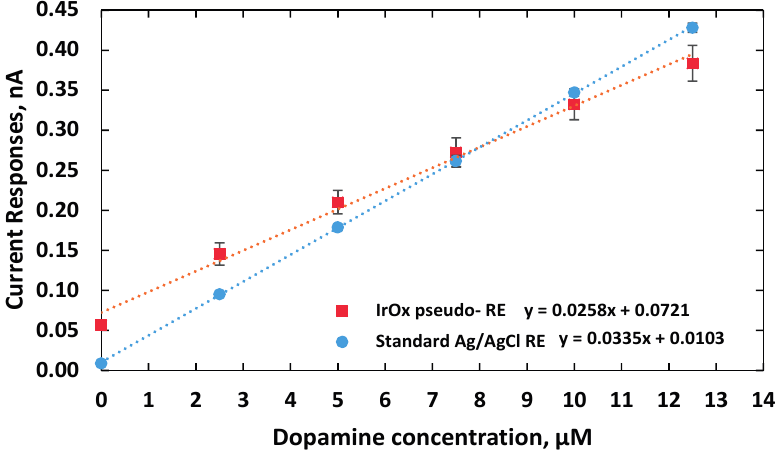
Figure 8. The sensitivity (slope) and repeatability (indicated by the standard error of the mean, SEM) of two DA sensors after three trials. Both sensors have gold working electrodes with a size of 50 μ m ×100 μ m. One sensor has an external IrO x pseudo-RE (red line). The other sensor used an external standard Ag/AgCl reference probe (blue